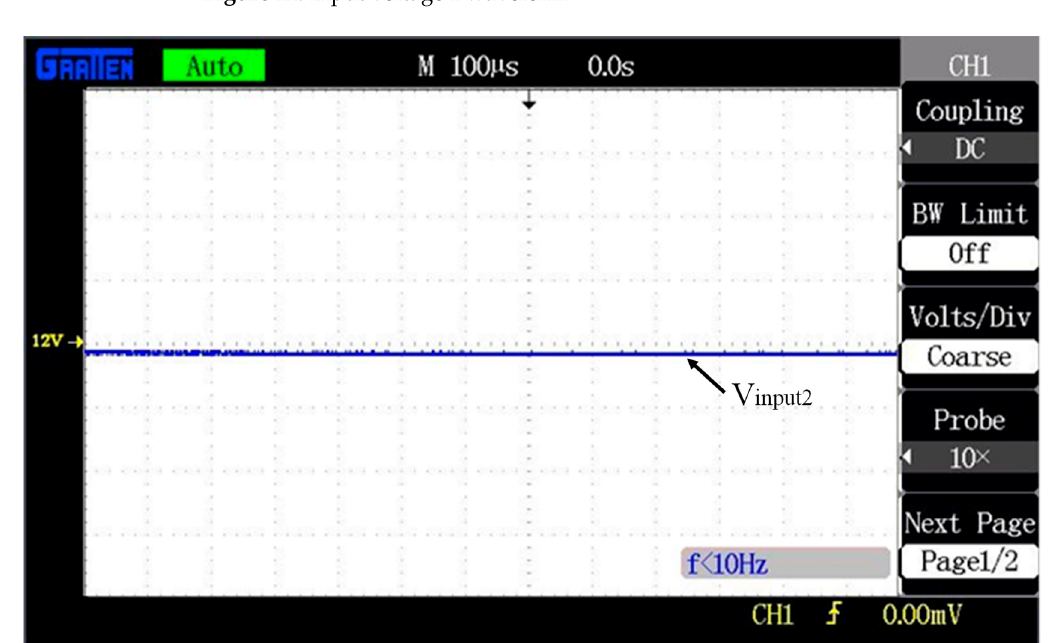
Figure 12. Input voltage 1 waveform.